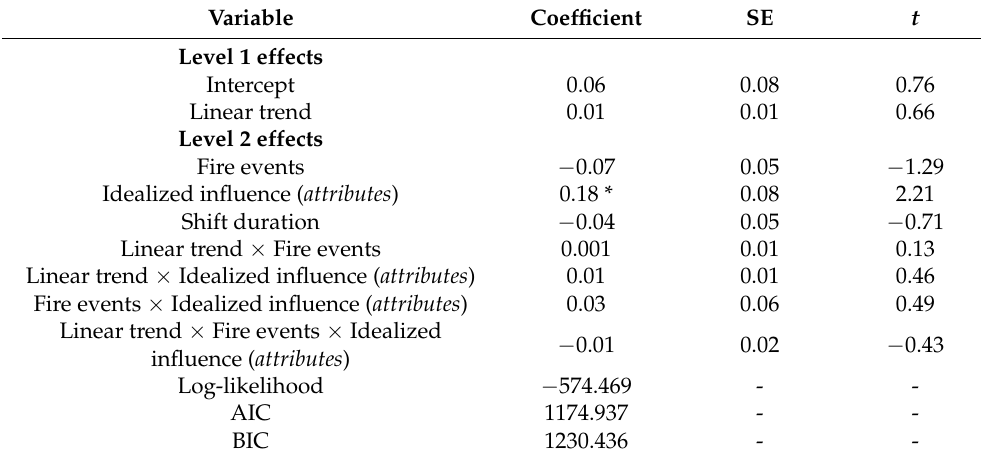
Table A2. Fire Events and Idealized Influence (Attributes) Predicting Change in Work Engagement.